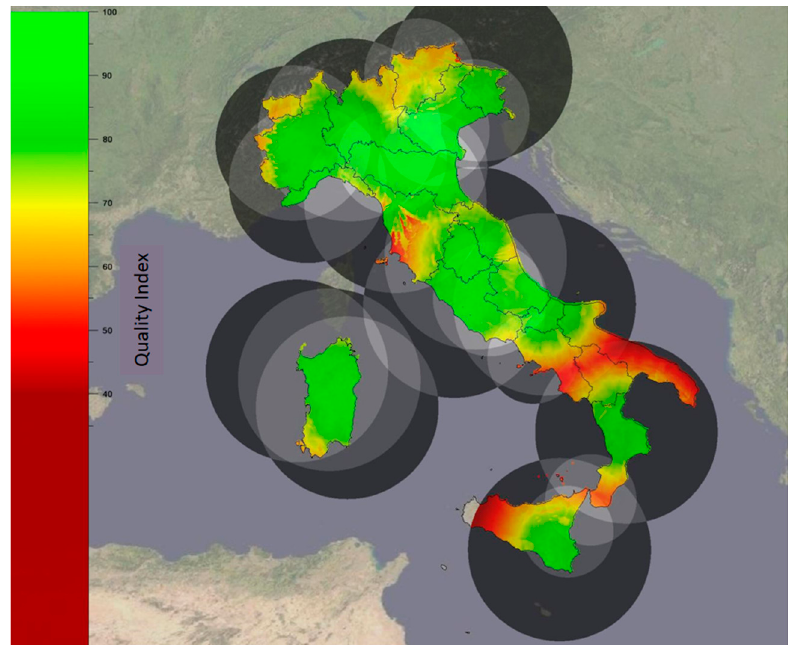
Figure 1. Italian ground radar network (IT GR) spatial coverage and its associated Quality Index (QI).